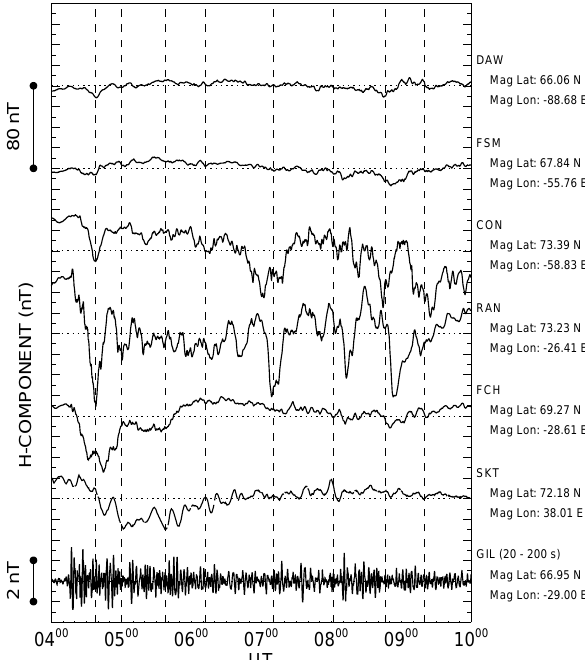
Fig. 7. H -component magnetic field measurements from the red colour-coded array of stations in Fig. 1, for 04:00–10:00UT on 20 March 2002. The upper 6 curves show unfiltered H -component magnetic field measurements and the bottom curve shows filtered (20–200s) data. The vertical dashed lines correspond to the times of the bursts shown in Fig. 5. The station codes and locations in magnetic longitude and latitude are also shown.